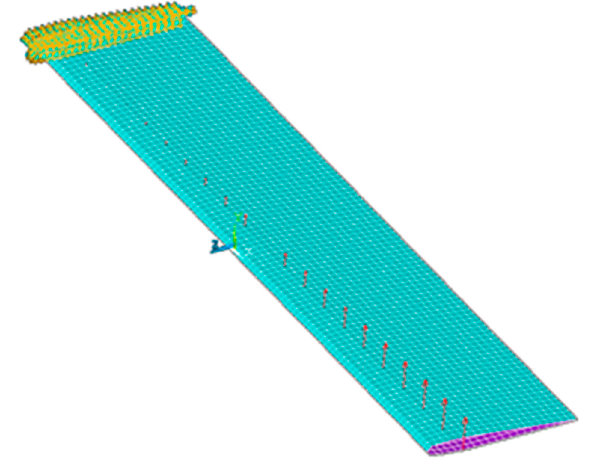
Figure 5. The finite element wing model with the aerodynamic loads being applied at a quarter of its chord (represented by the red arrows).